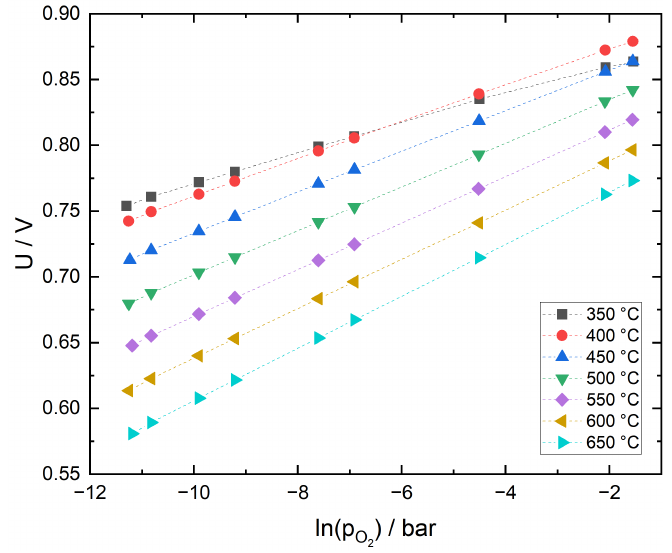
Figure 2. Sensor with Pt cermet sensing electrode, sensor voltage as function of oxygen partial pressure for different temperatures.